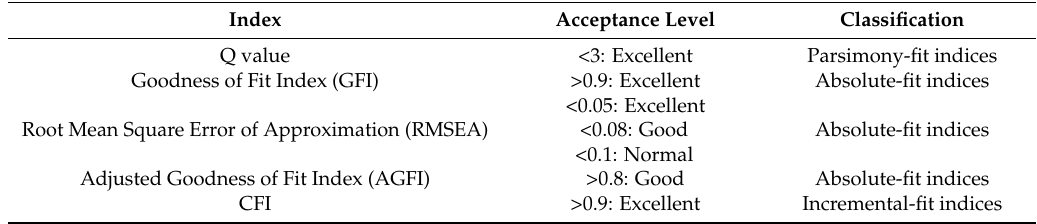
Table 2. Evaluation indices about structure goodness.